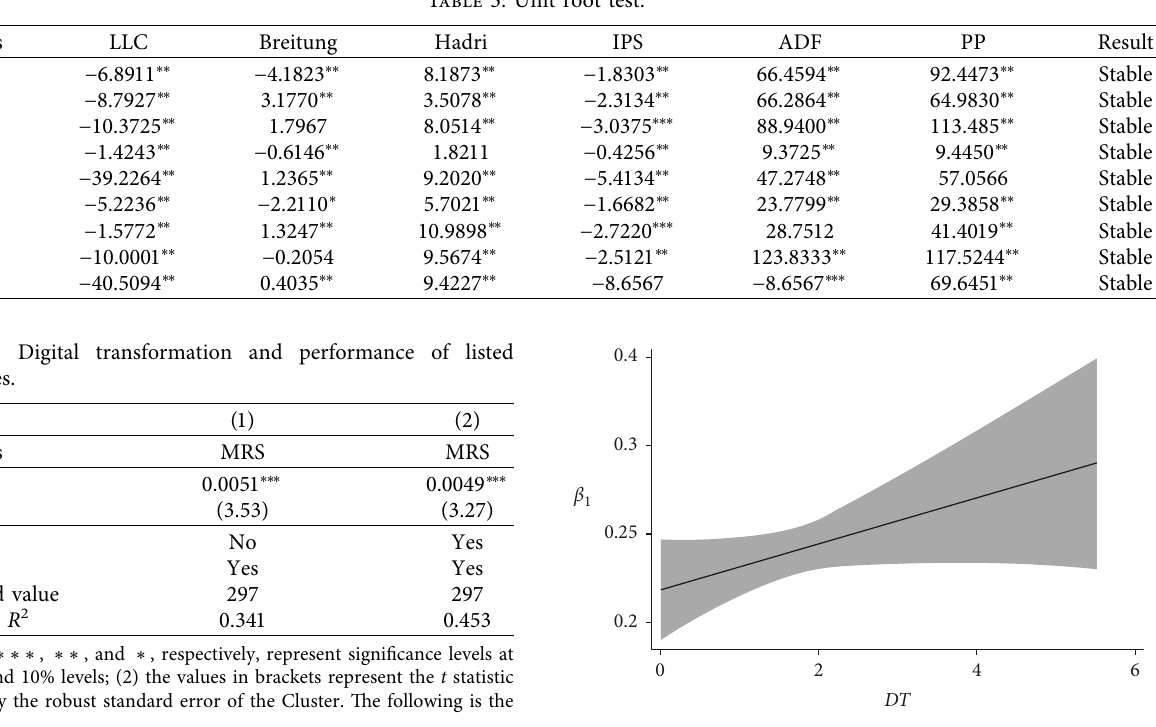
Figure 1: Marginal effect test. Table 5: Robustness test: changing the regression